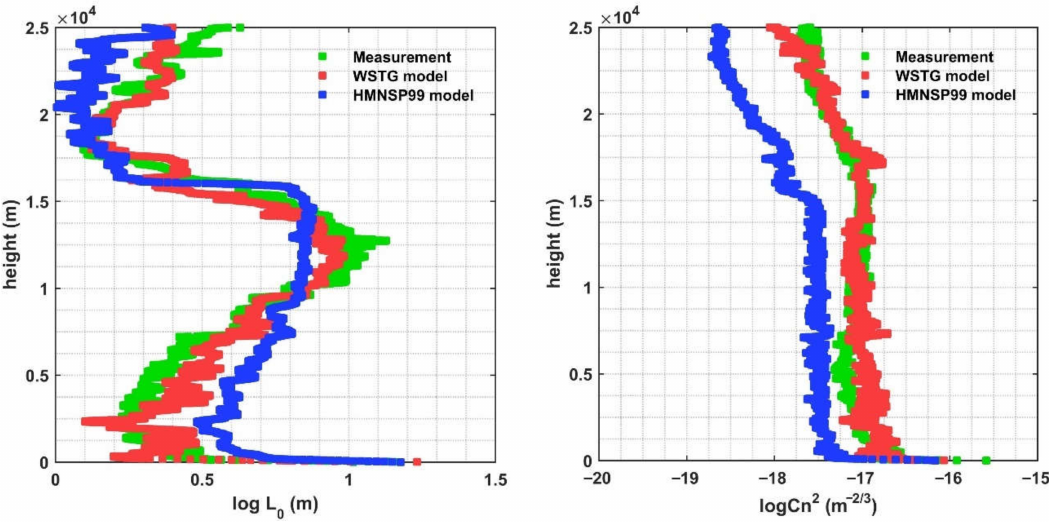
Figure 7. Statistically average profiles of L 0 and C 2 n from models and radiosonde